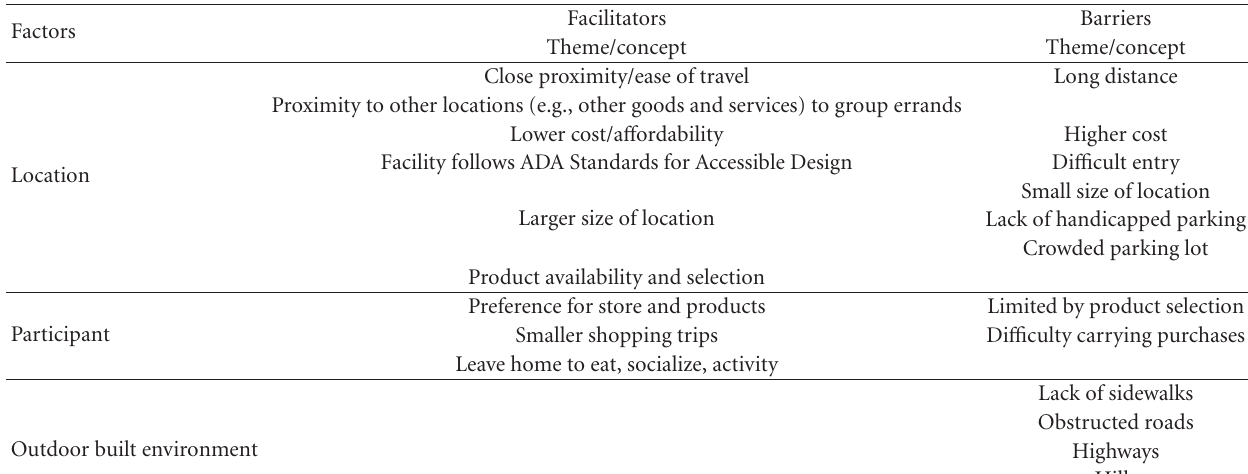
Table 2: Factors impacting choice of food access destinations.